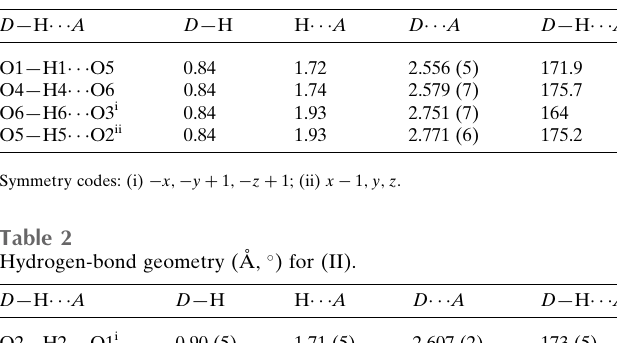
Table 1 Hydrogen-bond geometry (A˚ , (cid:3) ) for (I).